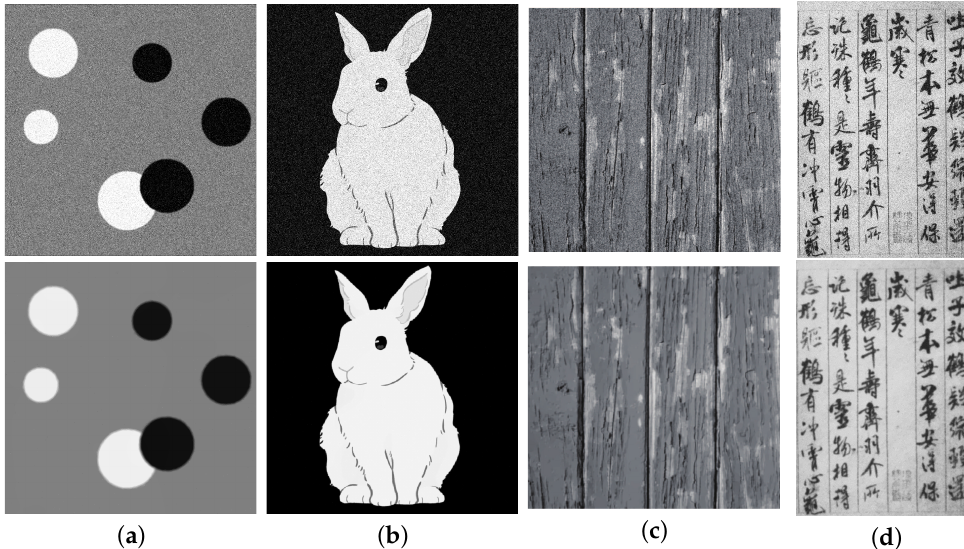
Figure 1. The first row is the initial image with 10% Gaussian noise and the second row is the obtained smoothing results. From ( a – d ), the image types are electronic composite image, JEPG compressed image, photo taken by camera, and scanning image, respectively.